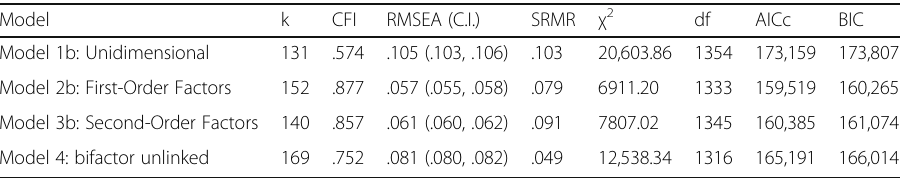
Table 2 Model fit statistics for the confirmatory factor analysis (CFA) models ( N = 1299)